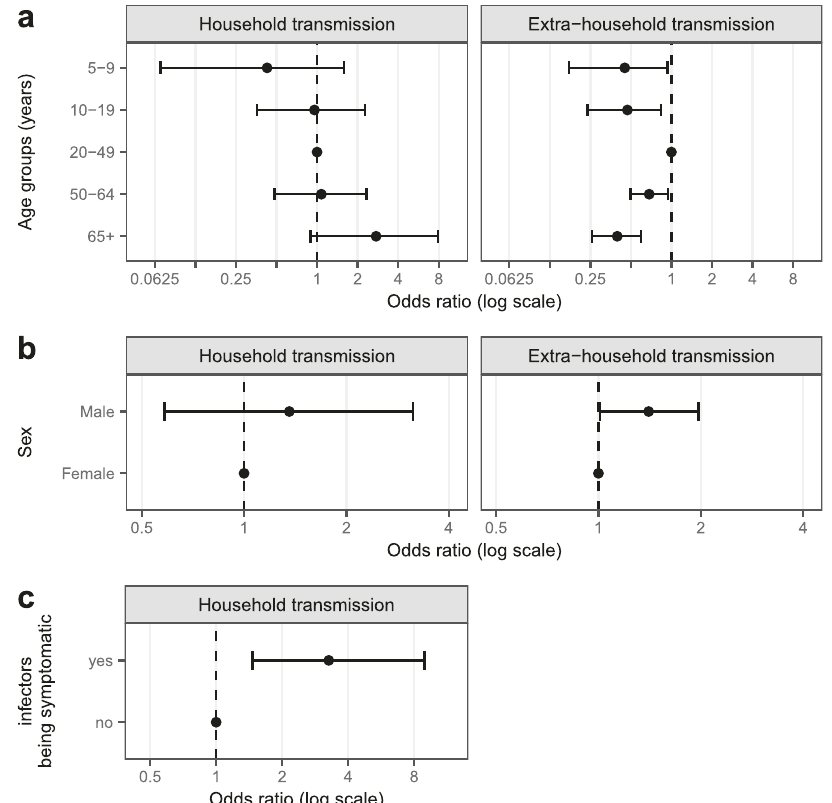
Fig. 3 Risk factors of SARS-CoV-2 infection and transmission. Relative odds of being infected outside the household and from a single infected household member by individual characteristics of the exposed individuals, a age group, b sex, and c potential infectors ’ symptom status. Odds ratios and credible intervals, shown on the log-scale, are estimates from model 4 (see Table